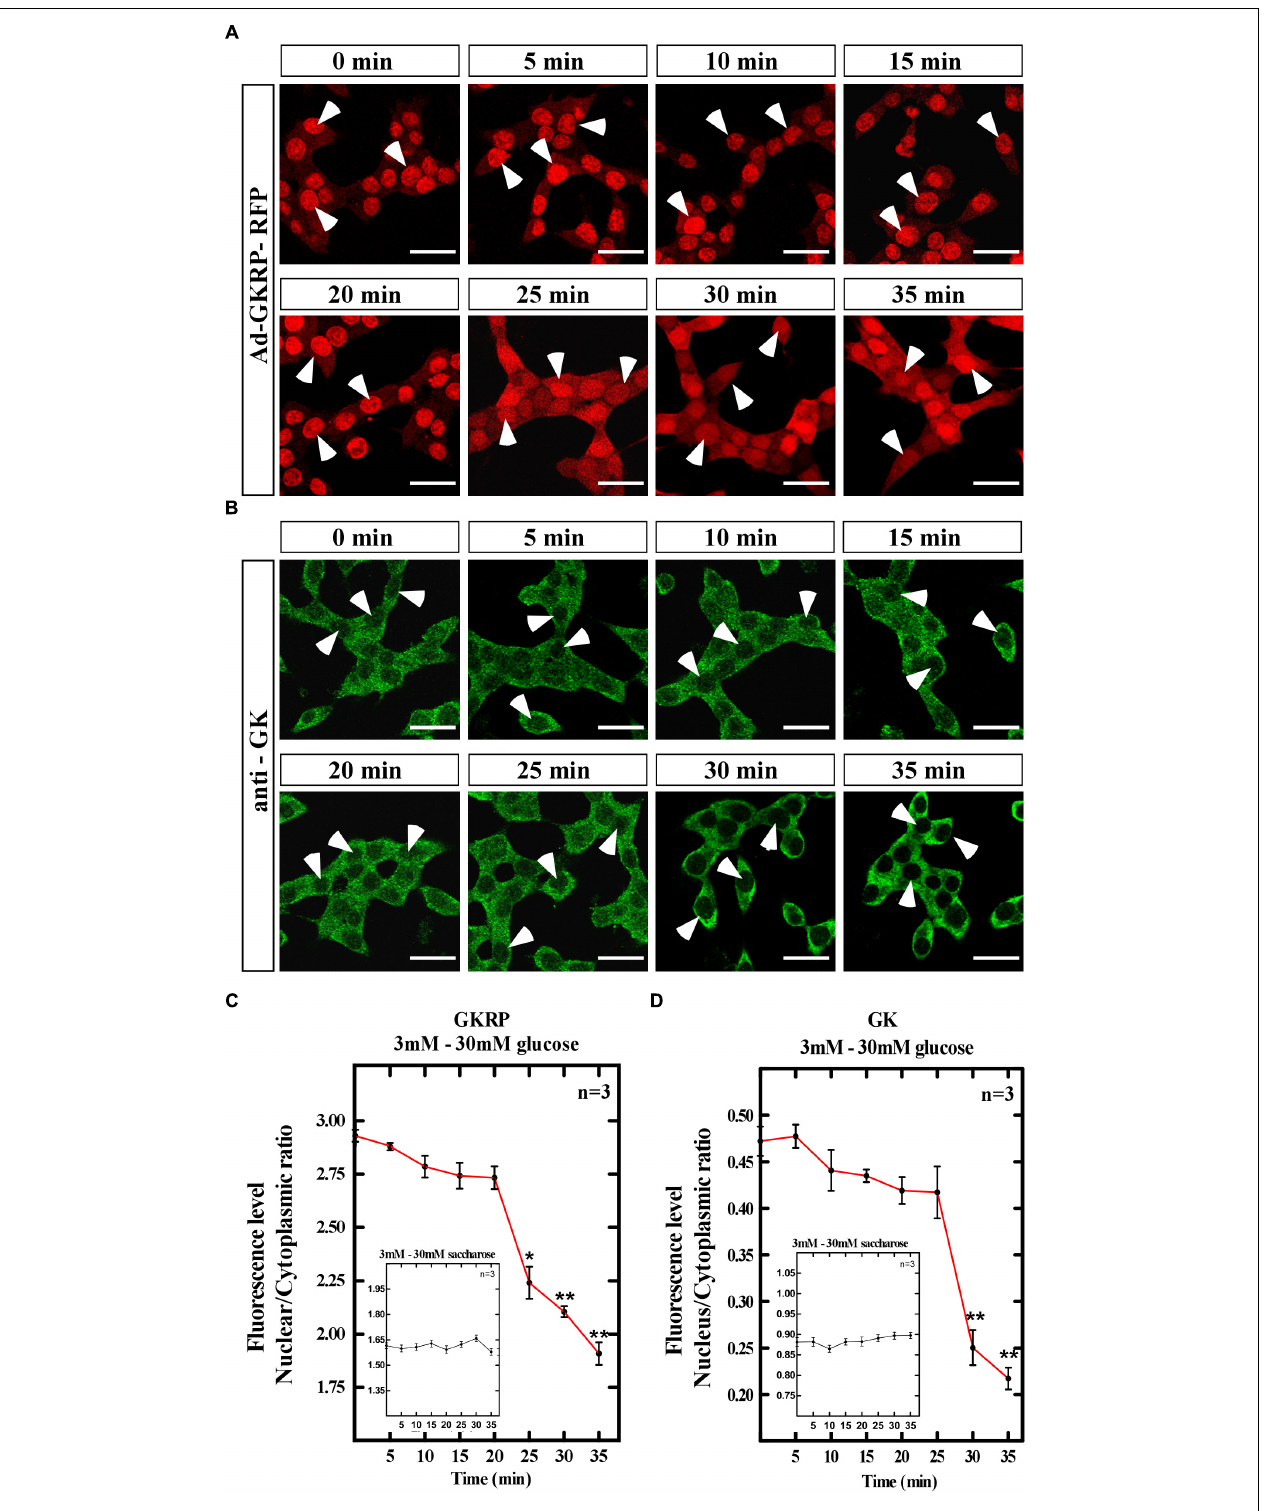
FIGURE 3 | Translocation dynamics for GK and GKRP in insulinoma cells overexpressing GKRP at increasing glucose concentrations. Transducted insulinoma cells were cultured for 3 h at 0.5 mM glucose with a posterior increase to 50 mM glucose for 30 min. (A) Dynamic subcellular localization of GKRP through fluorescence detection of RFP. (B) Dynamic subcellular localization of GK through immunocytochemistry. Scale Bar 20 µ m. (C,D) Quantification of nuclear/cytoplasmic ratio measured by fluorescence intensity of both subcellular compartments for GKRP (C) and GK (D) . Inserted box: Saccharose control treatments. Statistical ANOVA, ∗ p -value < 0.05, ∗∗ p -value < 0.01. Arrowheads show the nucleus of insulinoma cells, indicating nuclear exclusion.